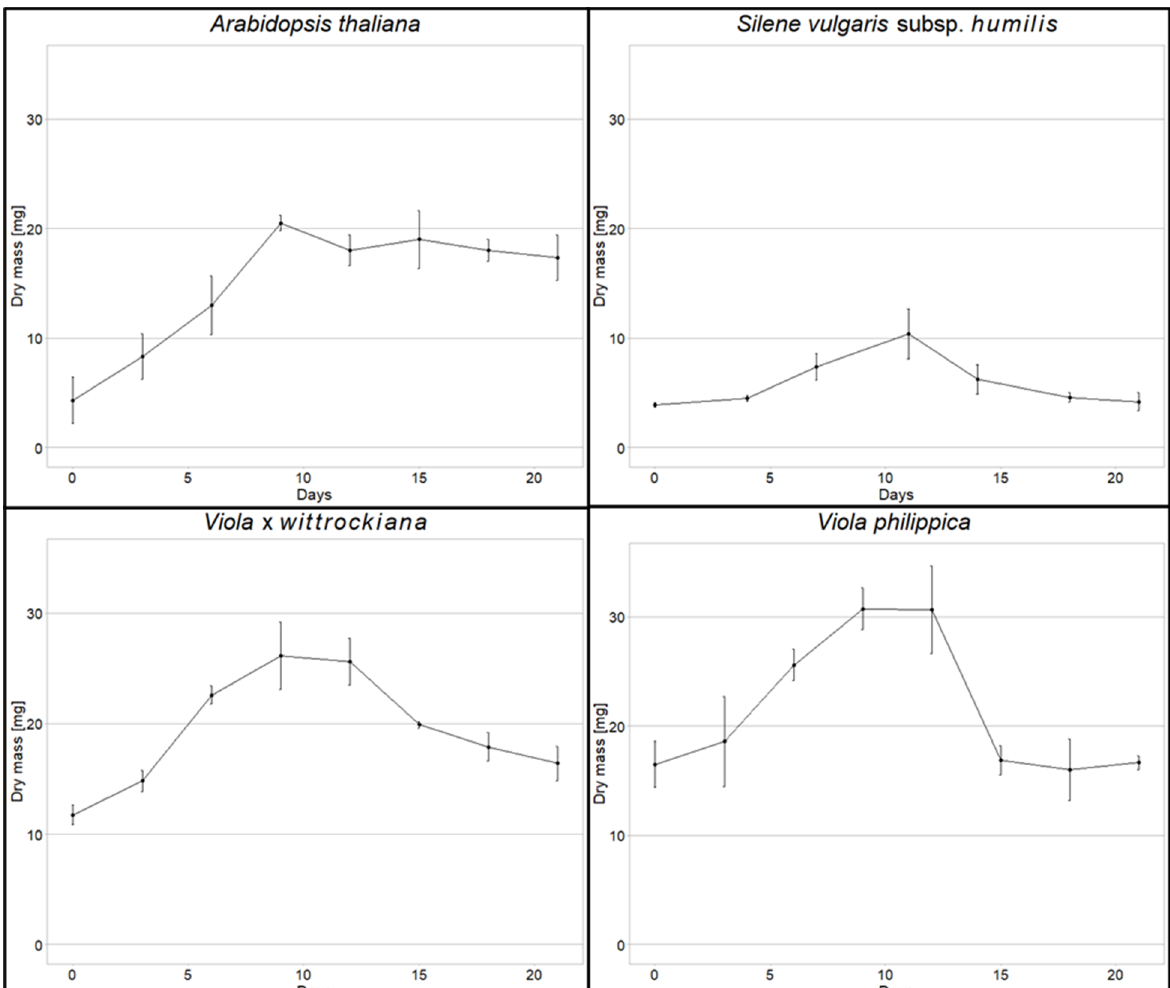
Figure 1. Plant cells growth in suspension monitored for 20 days. Each time point represents the mean value +/ − SD of 4 measurements of dry weight. Growth curve of V. tricolor (metallicolous population) could be found in Sychta et al. 2018 [11].